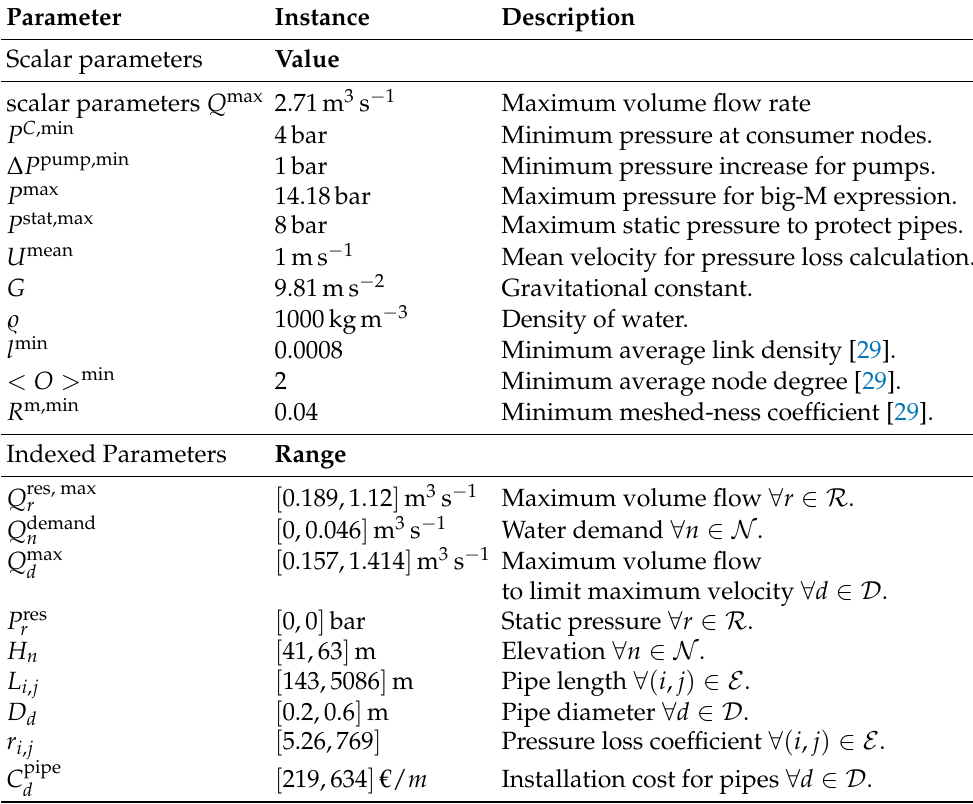
Table 5. Instance parameters defining the optimization